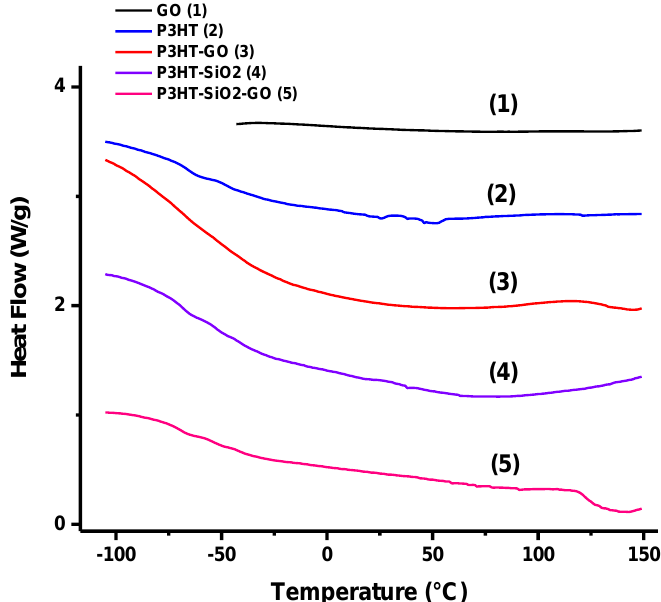
Figure 6. DSC curves for the model materials.